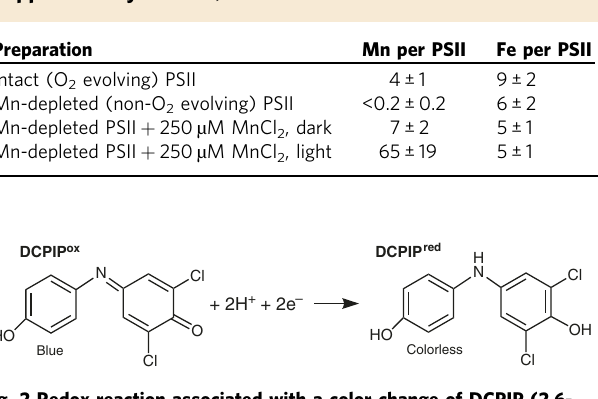
Table 1 Metal content of PSII preparations (for details, see Supplementary Table 1).